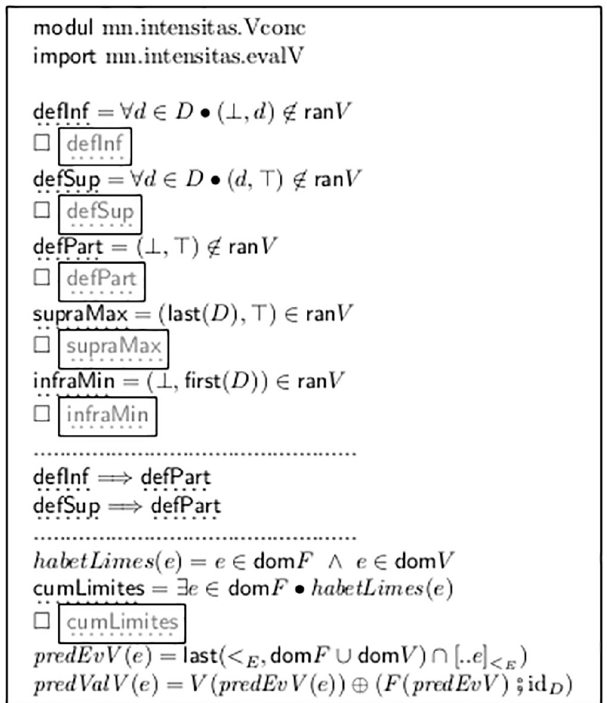
Fig 9. Conclusions from V .